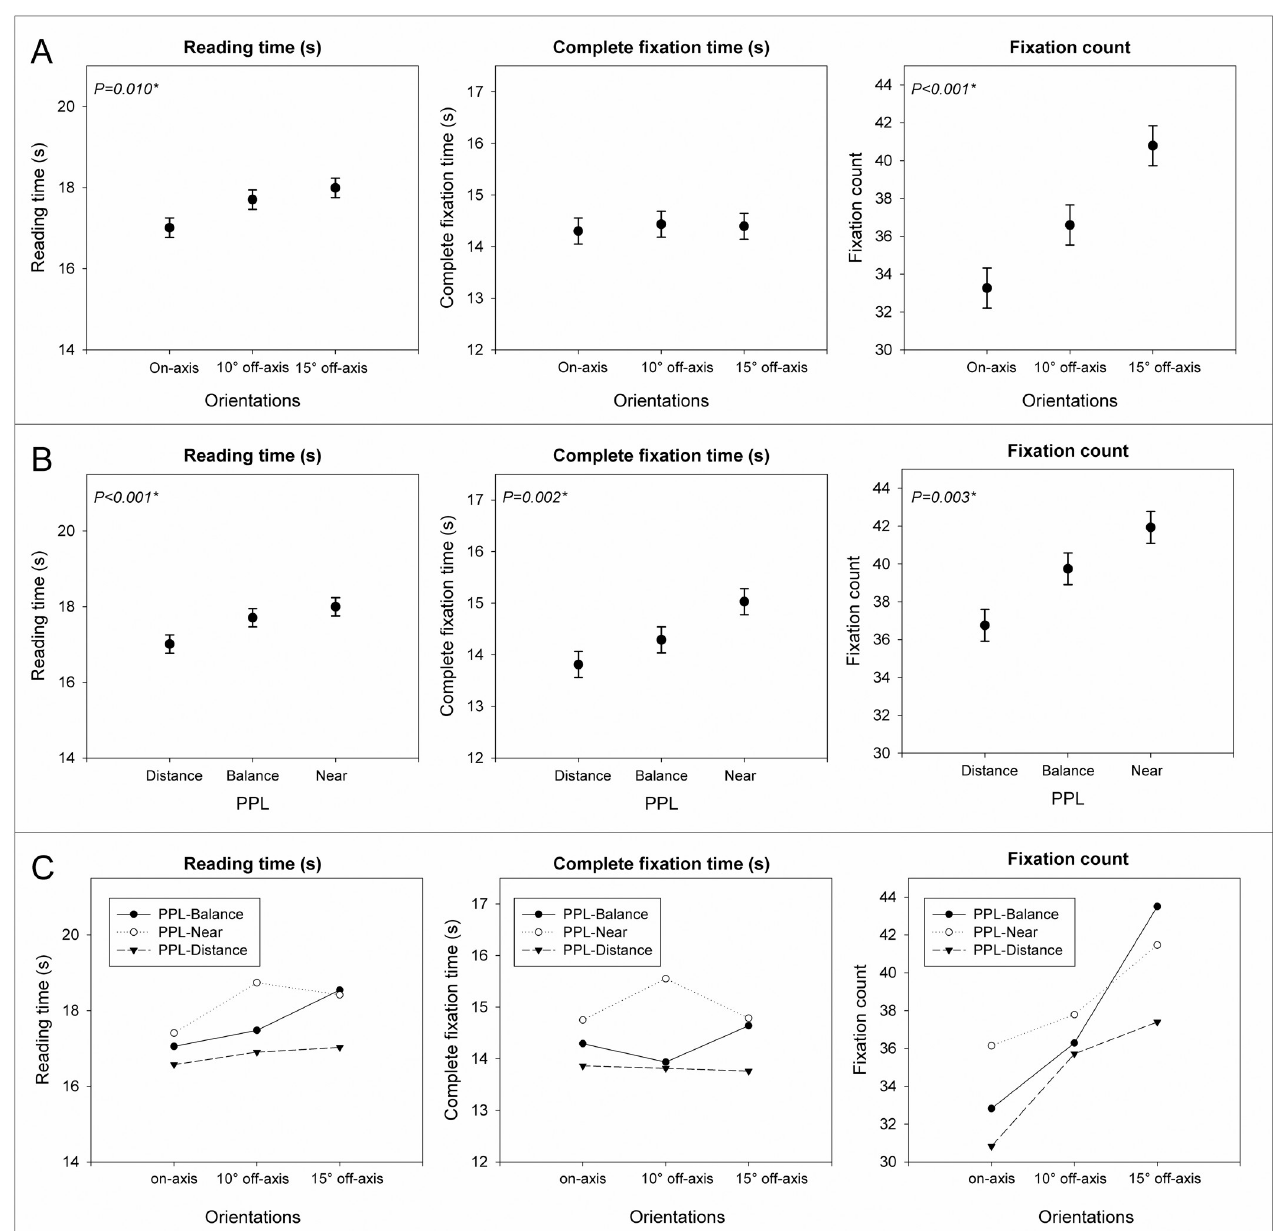
Fig 5. Variations in reading time, fixation time and fixation count depending on the PPL (A), the orientation (B) and the interactions of PPL and orientation (C) for distance-reading